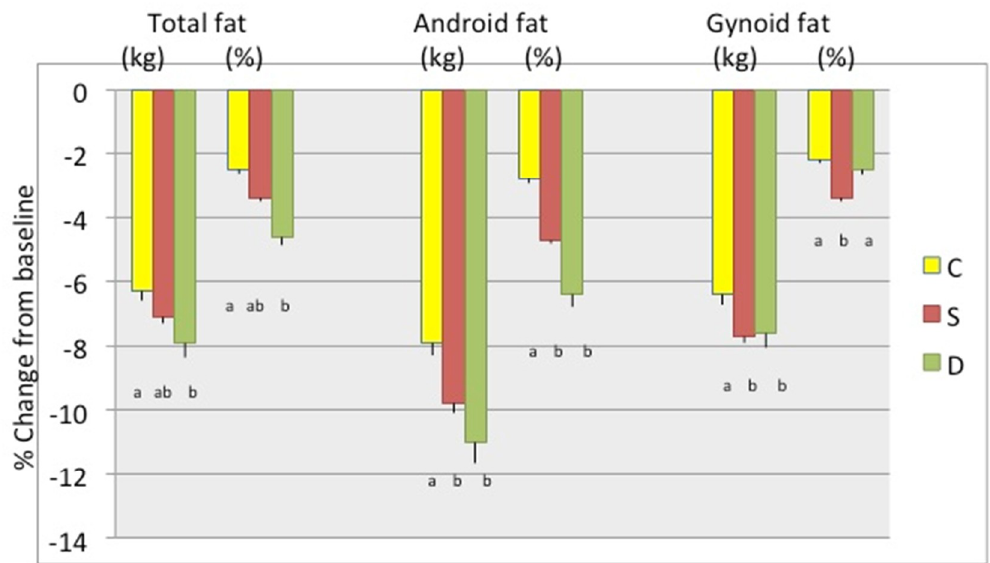
Figure 3. Percent change (mean ± SEM) in total body fat, android fat and gynoid fat (all kg and %), respectively, between baseline and 6 months among the groups. Only the complete data sets at baseline and 6 months were used: C-Control / placebo, n = 30; S-Supplement, n = 37; D-Dairy, n = 30. Bars with di ff erent letters indicate the statistically significant di ff erence among the groups at 6 months.